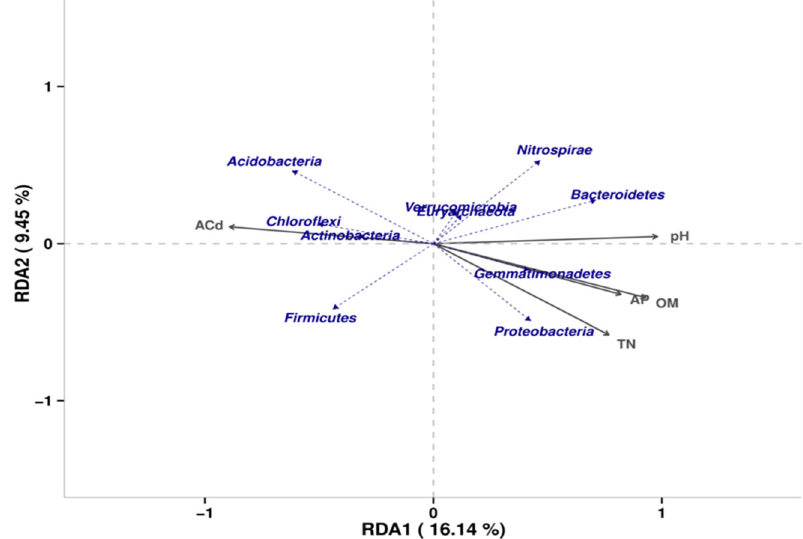
Figure 5. Redundancy analysis (RDA) including dominant bacterial community in different rice growth stages and soil properties as explanatory variables. RDA1 and RDA2 stand for two components reflects the sample difference to the greatest extent. The percentage stand for component contribution rate. The point represents the sample. The blue letters represent the top 10 dominant bacterial community and the gray arrows represent different environmental factors.